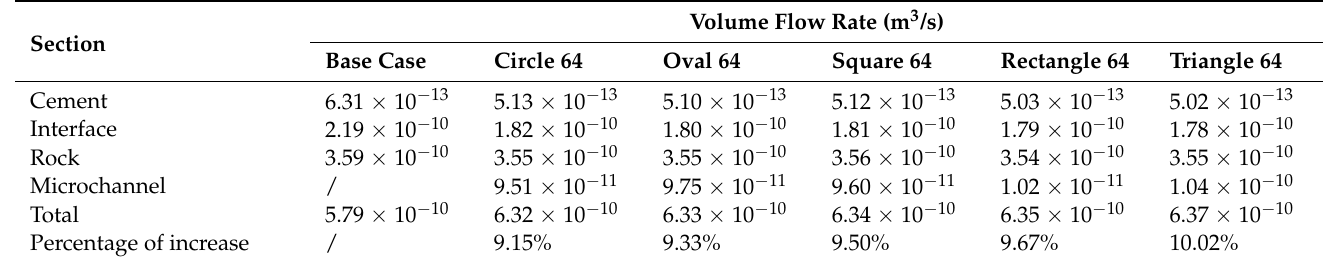
Table 4. Effect of micro channel shape on the volume flow rate through cement–rock sample: